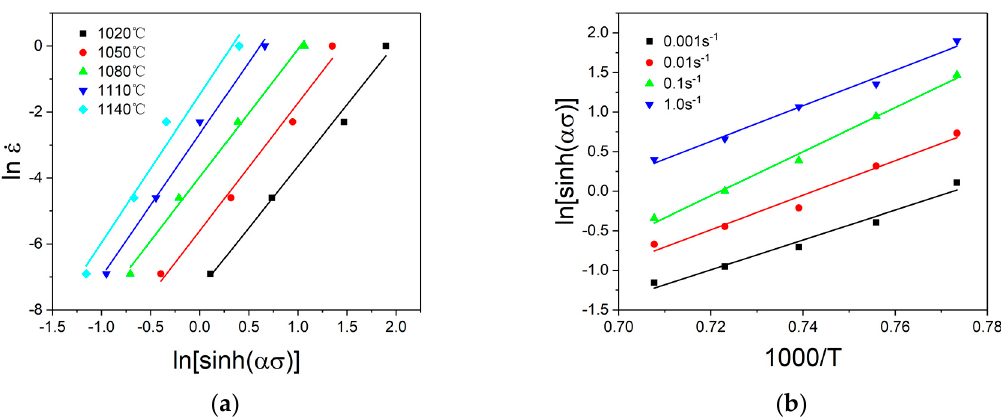
Figure 5. Relationship of the PM/Wrought dual superalloy between: ( a ) ln ε and ln[sinh( α )] σ ; ( b ) ln[sinh( α )] σ and (1000 / ) T .